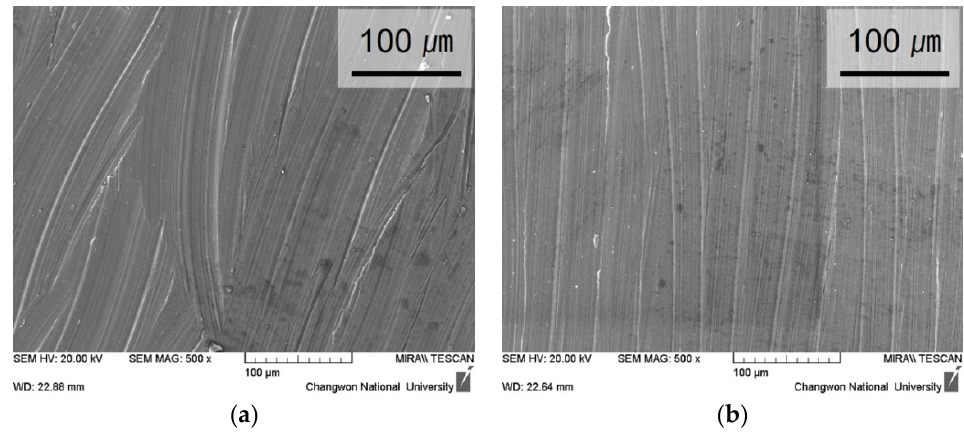
Figure 9. Microphotographs of machined surfaces: ( a ) conventional end milling; ( b ) laser-assisted end milling (spindle speed: 5000 RPM, feed rate: 200 mm/min, depth of cut: 0.7 mm).